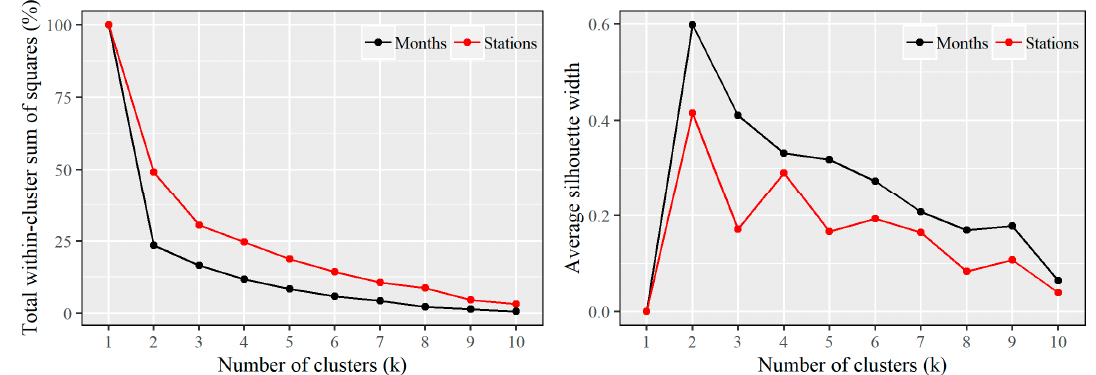
Figure 4. Total within-cluster sum of squares and average silhouette width versus number of clusters (k) while considering meteorological characteristics monthly and station-wise.